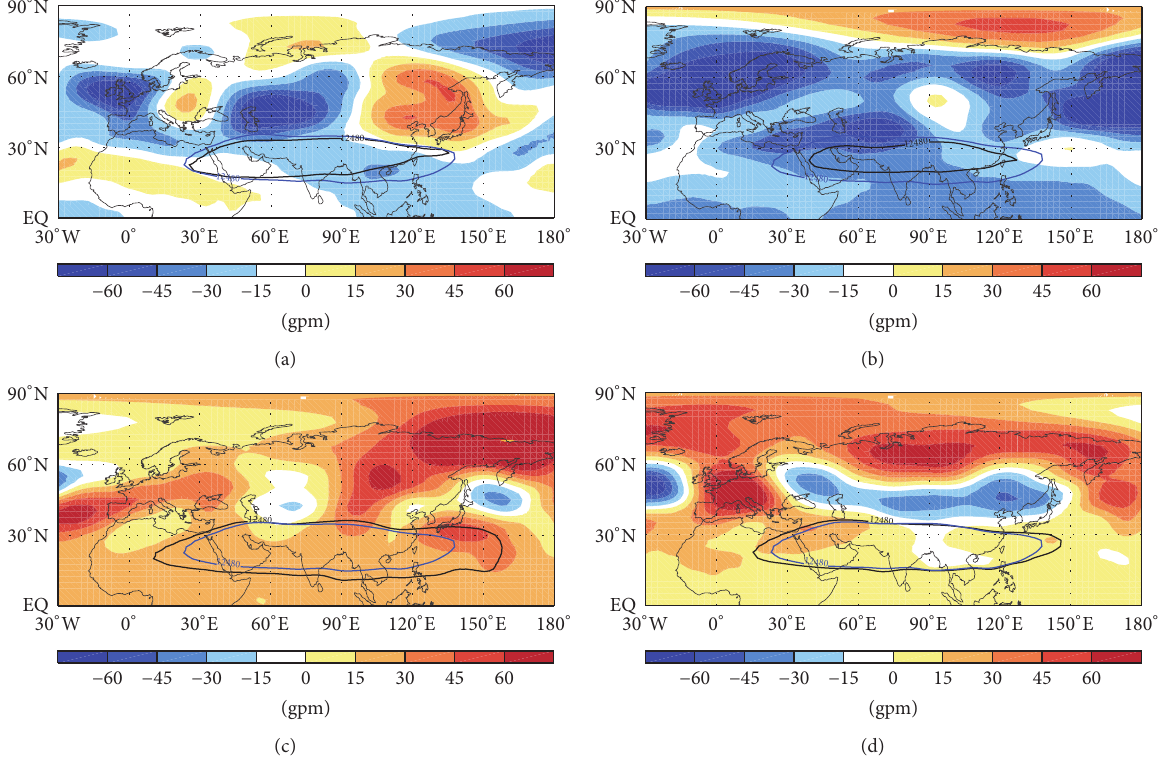
Figure 12: 200 hPa GPH anomalies (shading) (units: gpm) of the SDNF pattern in the summers of (a) 1963, (b) 1965, (c) 1991, and (d) 2003; blue lines denote the climatology of 12480 gpm and black lines indicate 12480 gpm for the typical